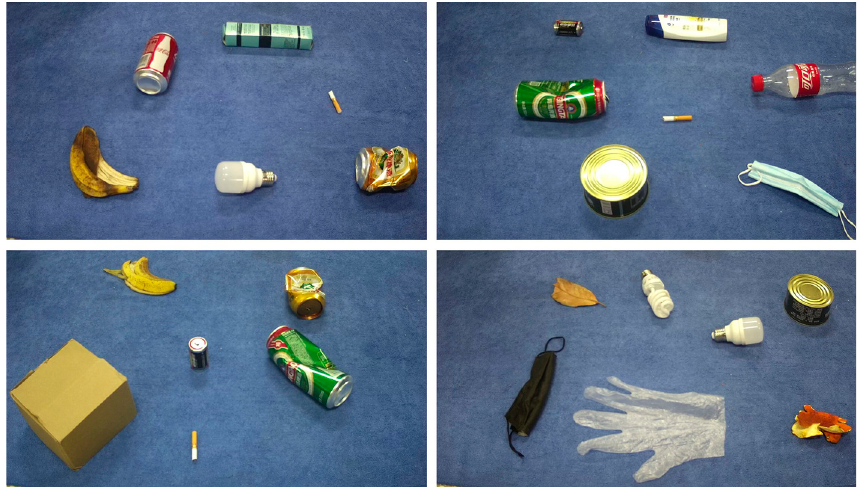
Figure 7. HPU_WASTE dataset image example.